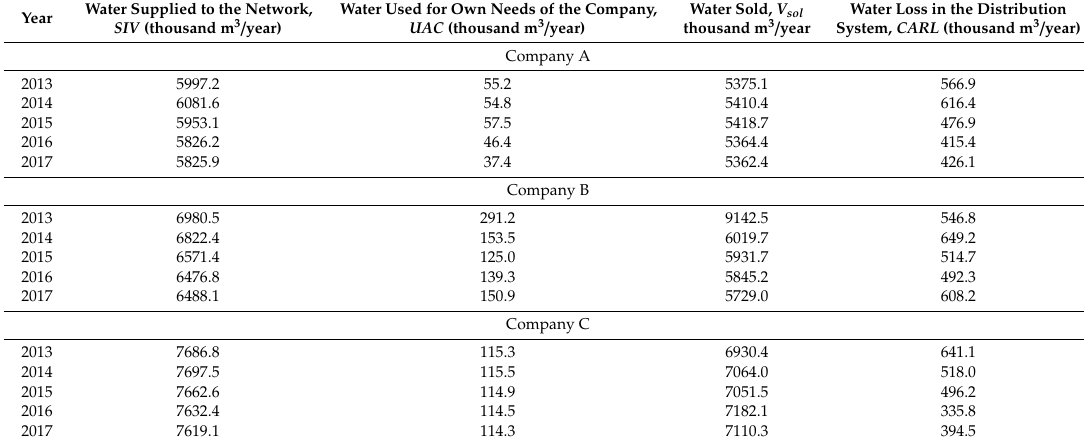
Table 2. Summary in water balance in